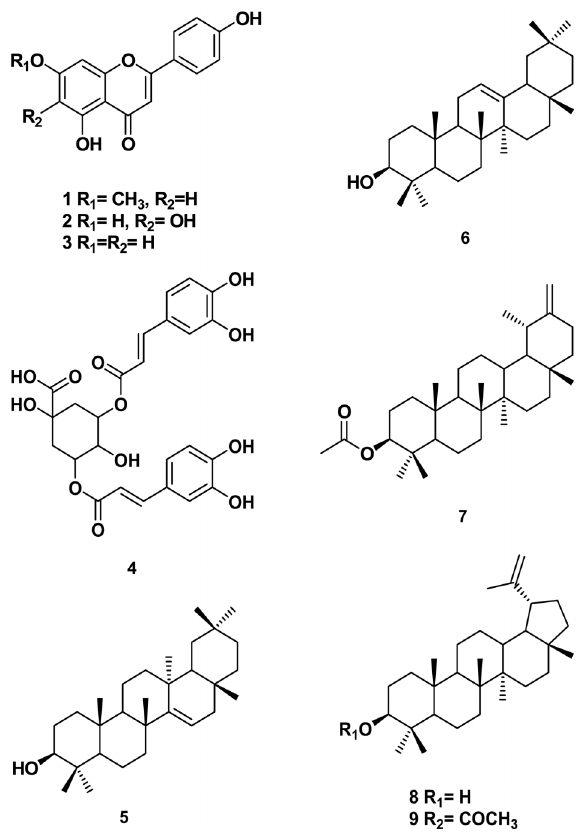
Figure 1. Chemical structures of the compounds identi fi ed in Gochnatia pulchra : genkwanin (1); scutellarin (2); apigenin (3); 3,5-O-dicaffeoylquinic acid (4); epitaraxerol (5); b -amyrin (6); taraxasterol acetate (7); lupeol (8); and lupeol acetate (9).